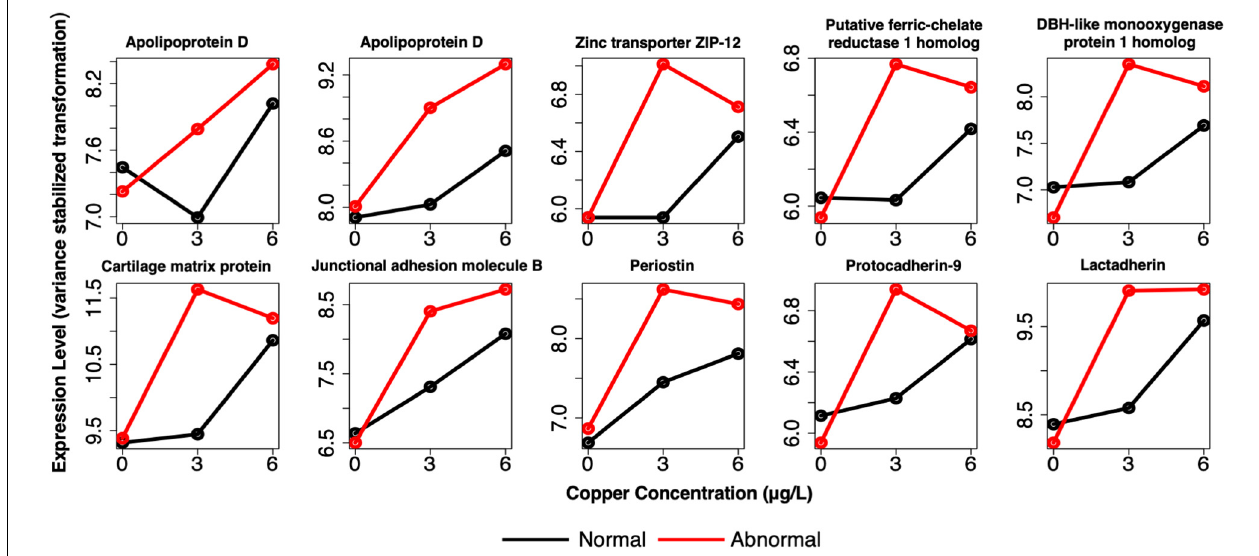
FIGURE 10 | Example expression profiles in pooled larvae of a subset of the genes that were identified as both markers of exposure and effect. Genes are related to apoptosis, oxidative stress, shell formation, development, cell adhesion, and divalent cation binding. Red lines depict expression of abnormal animals, and black lines depict expression of normal